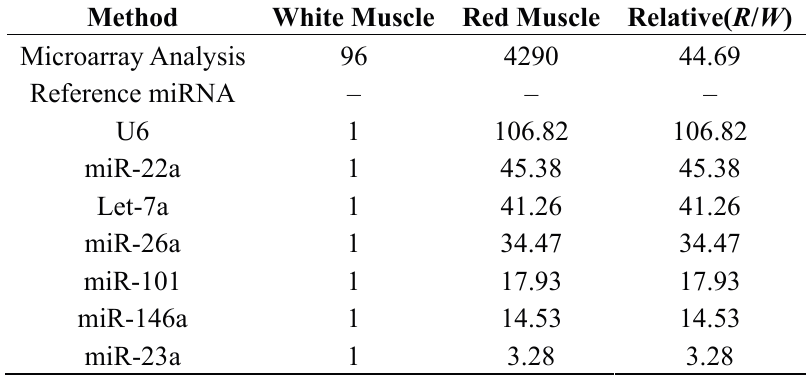
Table 7. Comparative profiling of the miR-499 expression in white muscle and red muscle of Siniperca chuatsi by microarray analysis and